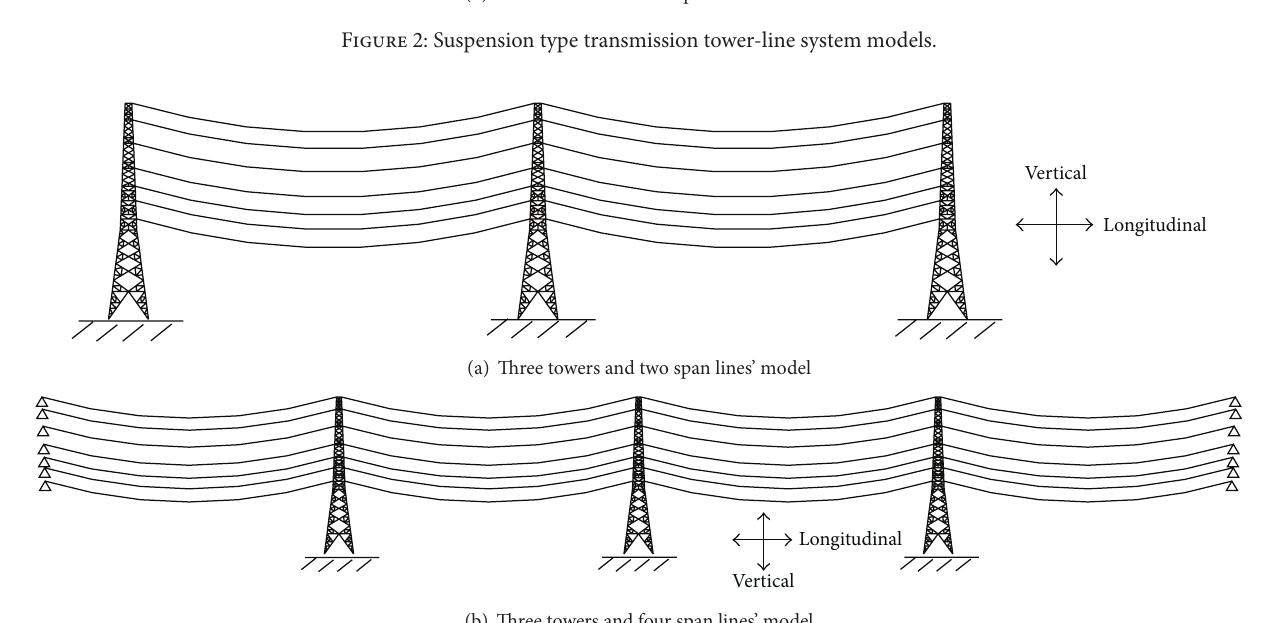
Figure 3: Tension type transmission tower-line system models.